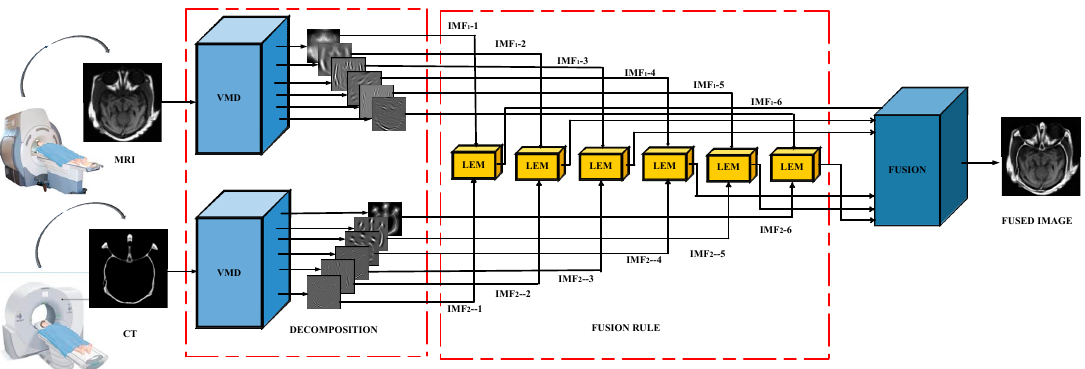
Figure 2. Proposed MRI-CT medical image fusion scheme.